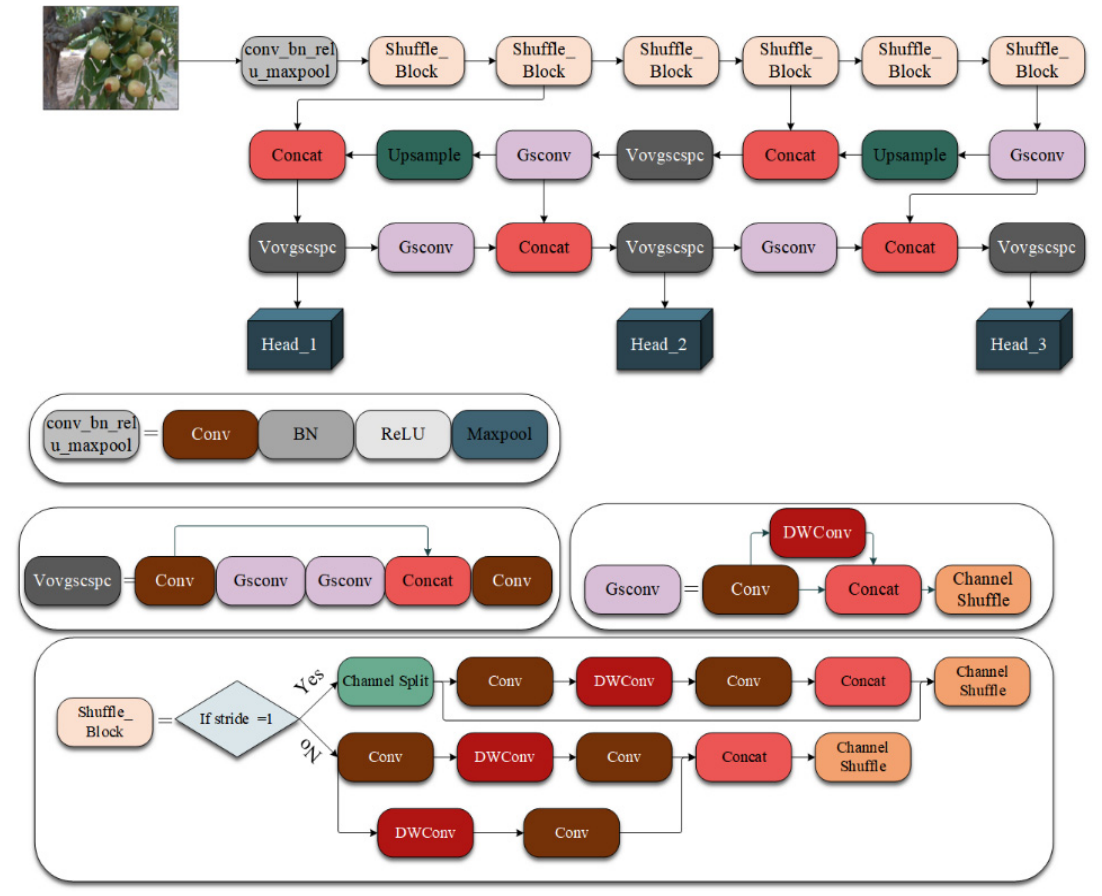
Figure 8. The structure of improved Yolov5s model. Where conv_bn_relu_maxpool is composed of Conv, Bn, ReLu and Maxpool; Bn is the Batch normalization; ReLu is the Rectified Linear Unit; Maxpool is the operation to calculate the maximum value of all elements in the pooling window. Table 3. The model performance with different lightweight